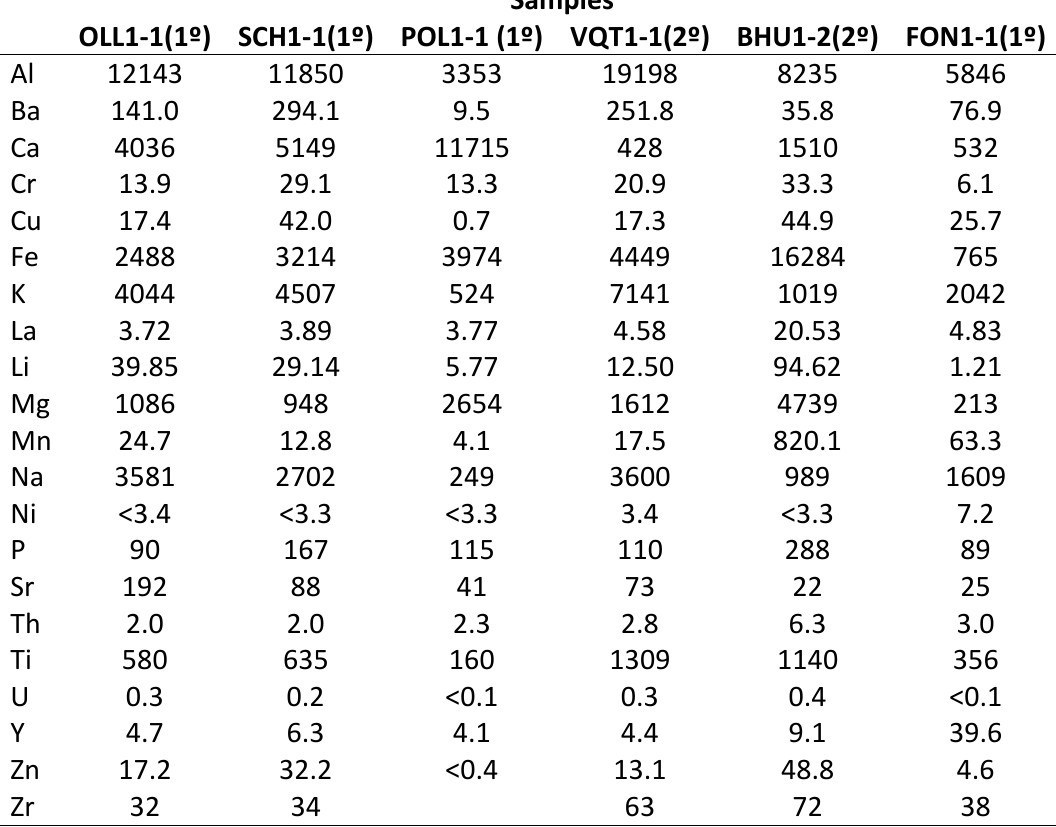
Table 5: ICP-OES samples results. Quantities are in ppm. The original contex of each reference is noted in the sample name: 1º for primary source, 2º for secondary